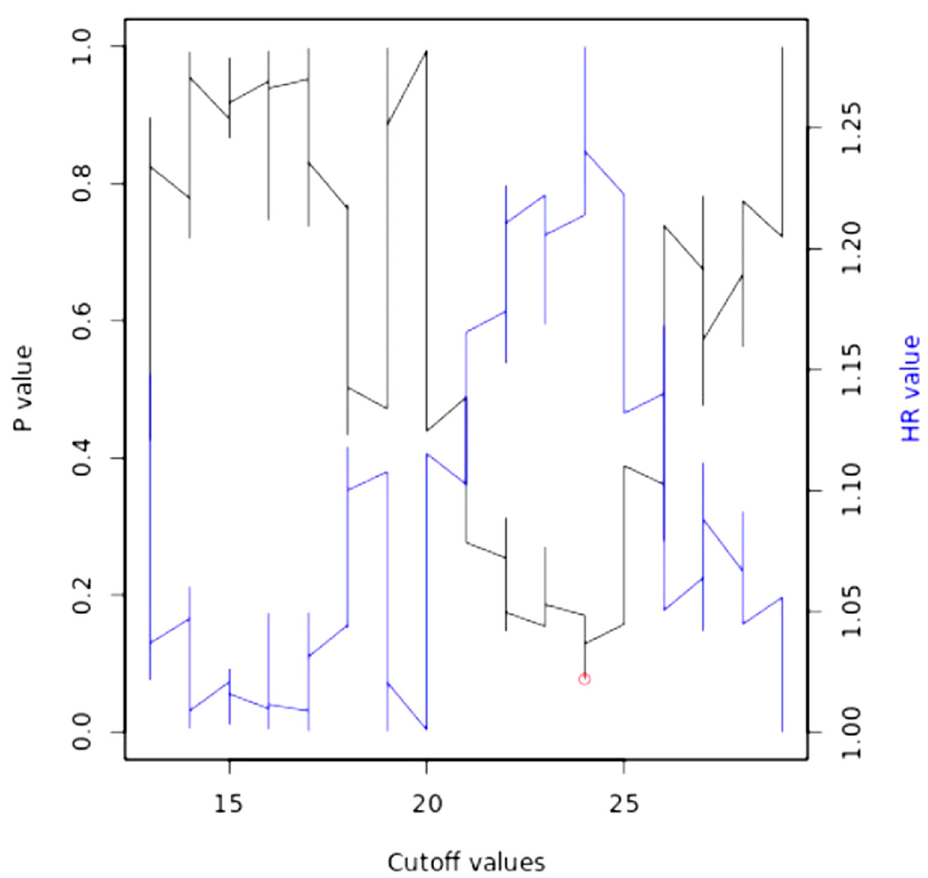
Figure 6. Auto cut-off plot. Significance vs. cut-off values between the lower and upper quartiles of expression.